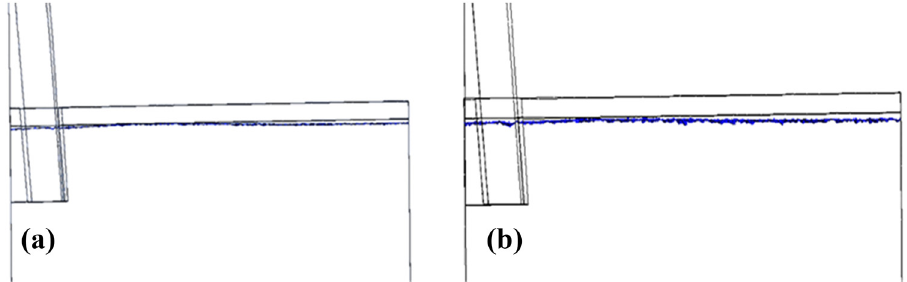
Figure 15: Funnel mold liquid level slag entrapment diagram: ( a ) 30 s and ( b ) 60 s.